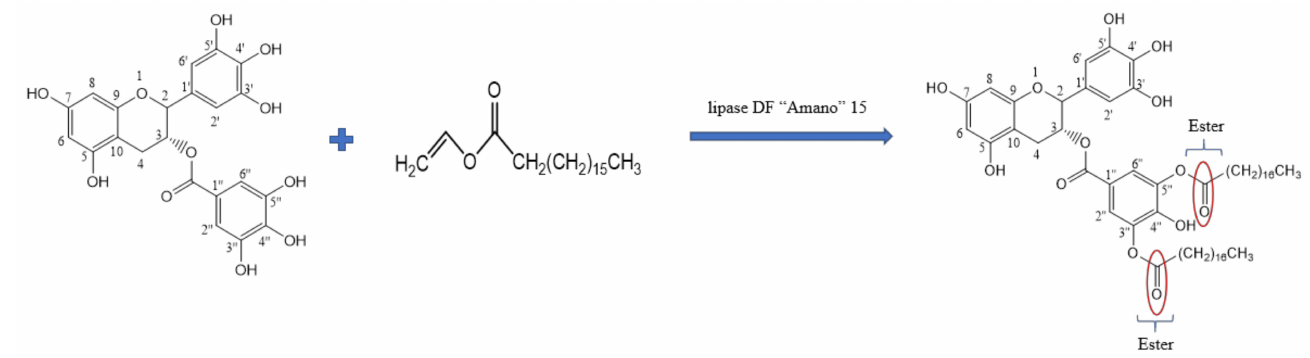
Figure 5. Schematic representation of enzymatic synthesis of di-stearyl